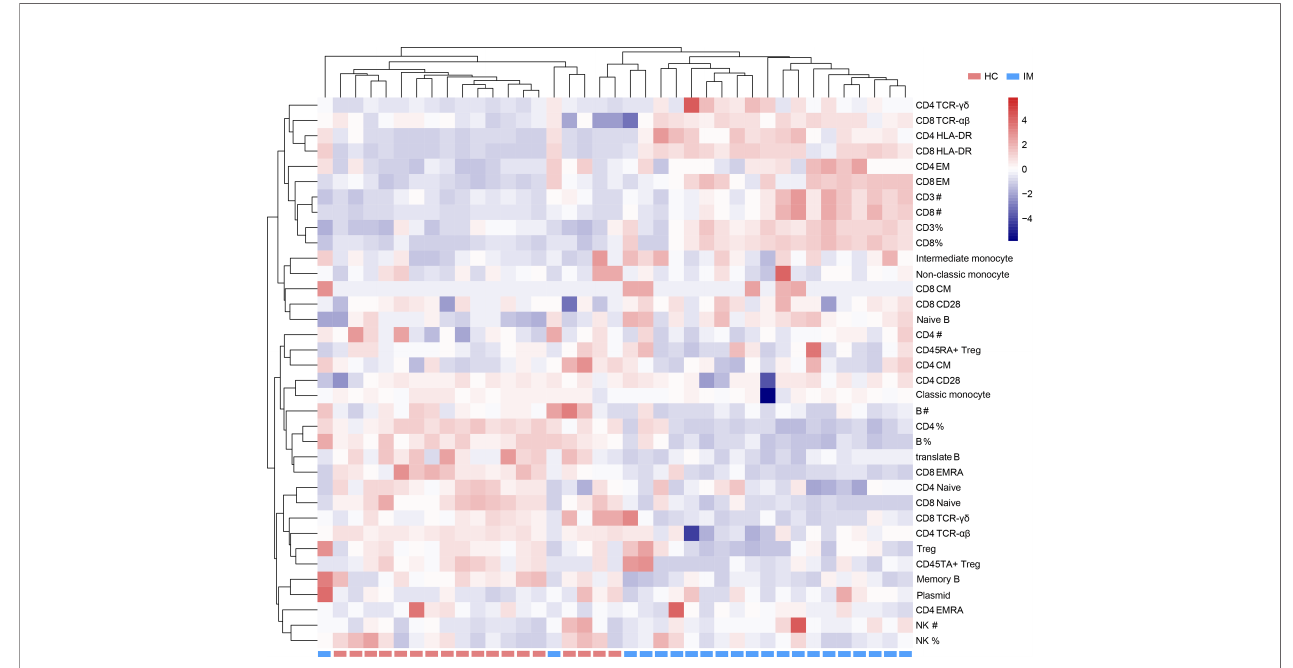
FIGURE 5 | Immunophenotypes of mononuclear cells were shown in a heatmap with unsupervised clustering